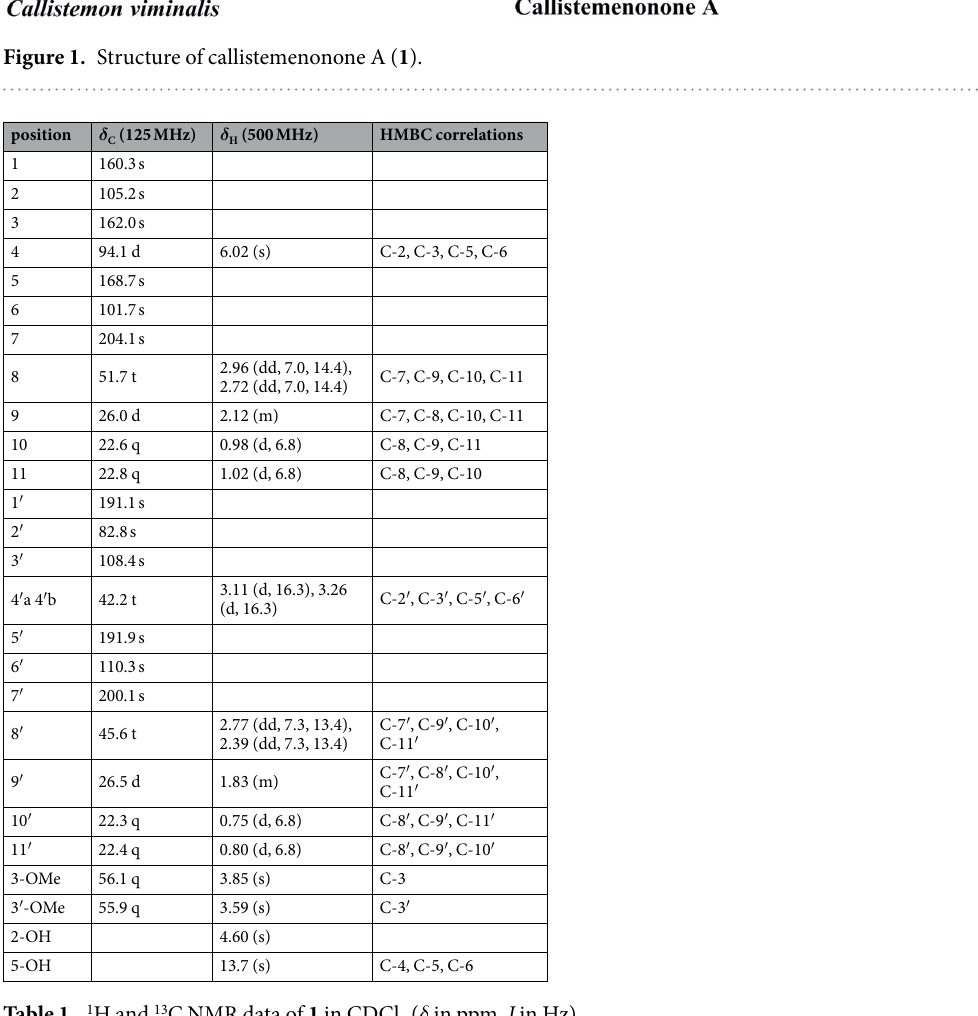
Table 1. 1 H and 13 C NMR data of 1 in CDCl 3 ( δ in ppm, J in